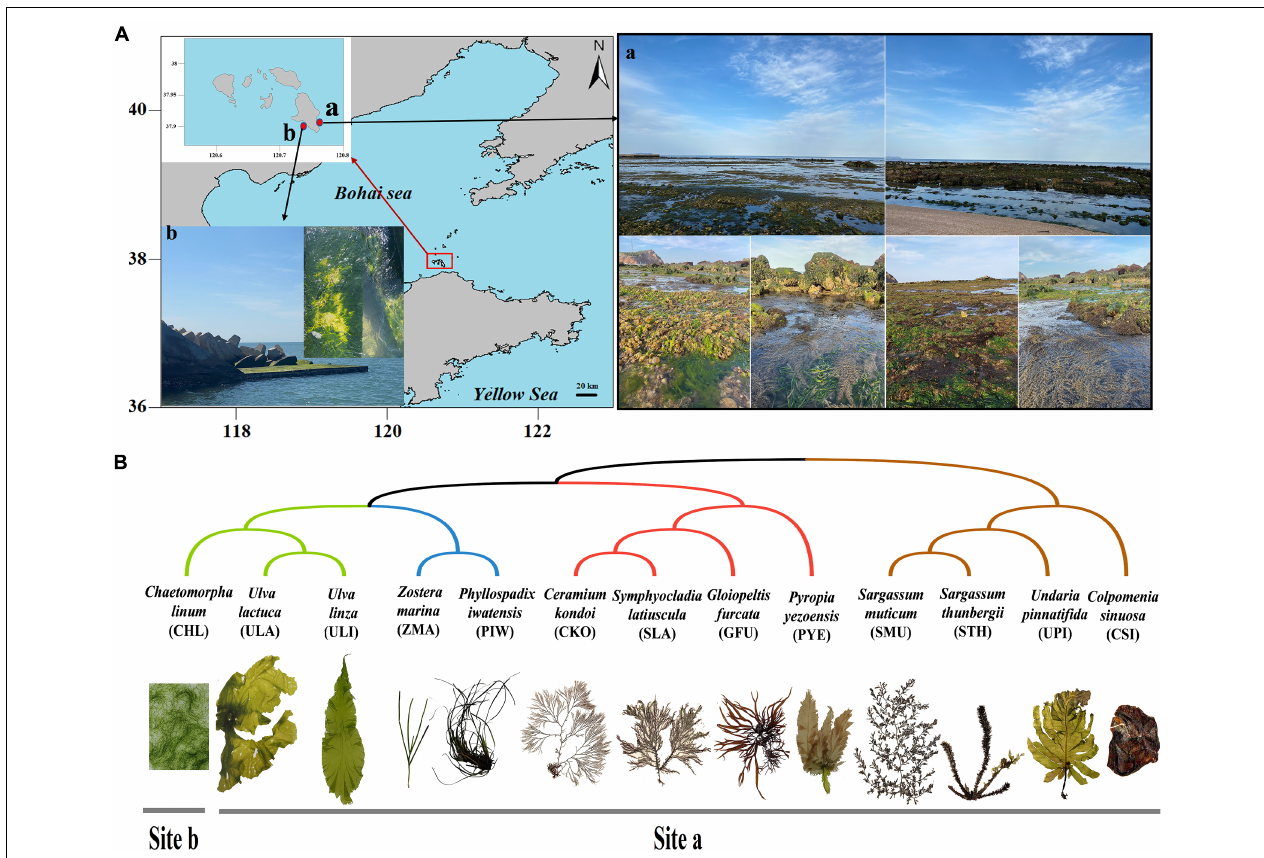
FIGURE 1 | Sample Information. (A) Sampling locations. (B) Phylogenetic relationships and collection locations of different marine